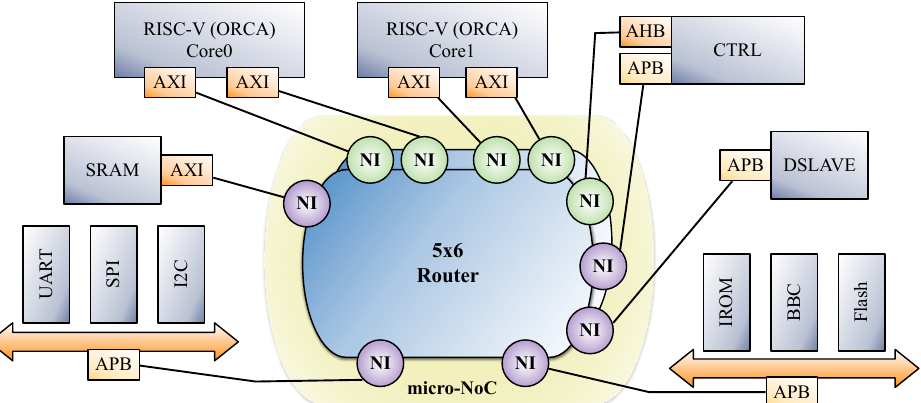
Figure 5. Architecture of the TEI-inspired SoC platform used for our target ULP SoC. In the figure, APB, AHB, and AXI are AMBA protocols, NI, and CTRL, respectively, representing the network interface and controller, and the rest are typical